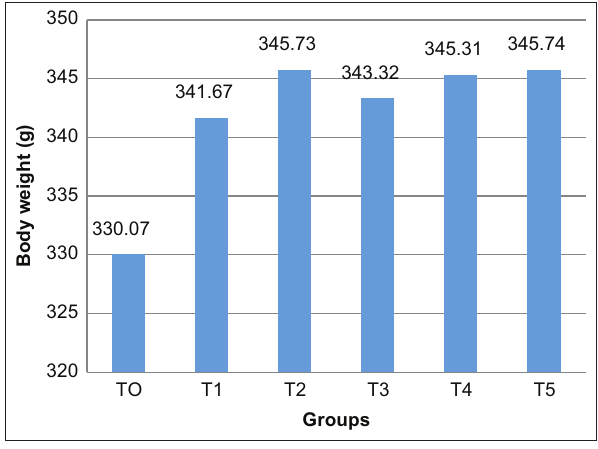
Figure-1: Efficacy of dietary supplementary probiotics on male layer chicken body weight during starter period. Values are expressed in mean±standard error. One-way analysis of variance was carried out followed by Duncan’s comparison test. a,b,c Different superscripts indicate significant differences